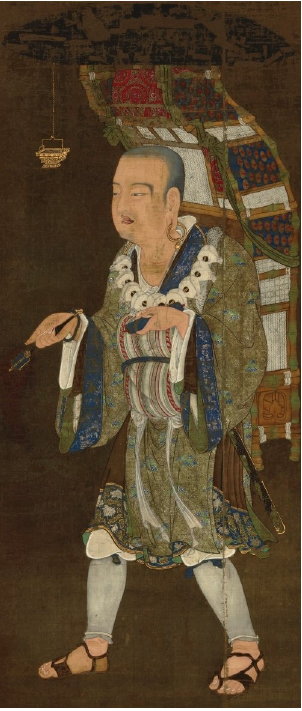
Figure 6 Figure 6. Portrait of Xuanzang as an Itinerant Monk . Kamakura period, 14th century. Ink and colors